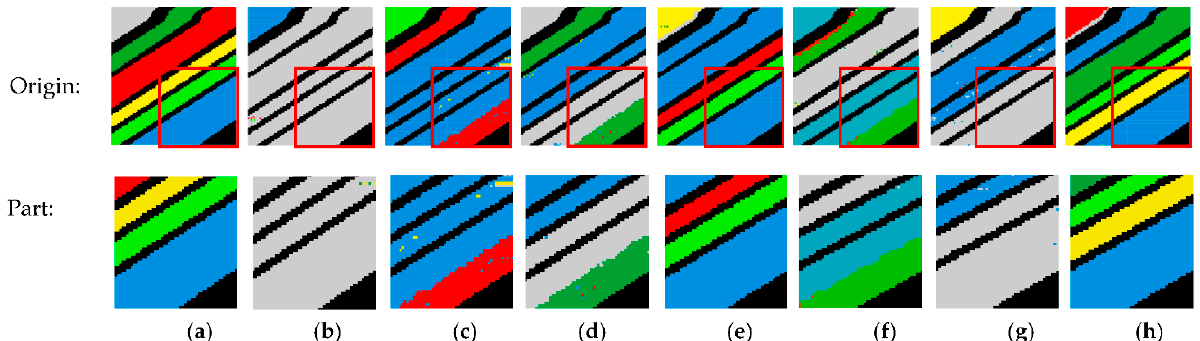
Figure 10. Clustering results obtained using different methods on the SalinasA data set with Gaussian noise. ( a ) Ground truth. ( b ) LRSC 35.96%. ( c ) SSC 47.61%. ( d ) S4C 54.77%. ( e ) EDSC 61.97%. ( f ) EGCSC 54.92%. ( g ) EKGCSC 60.73%. ( h ) SSAKGCSC